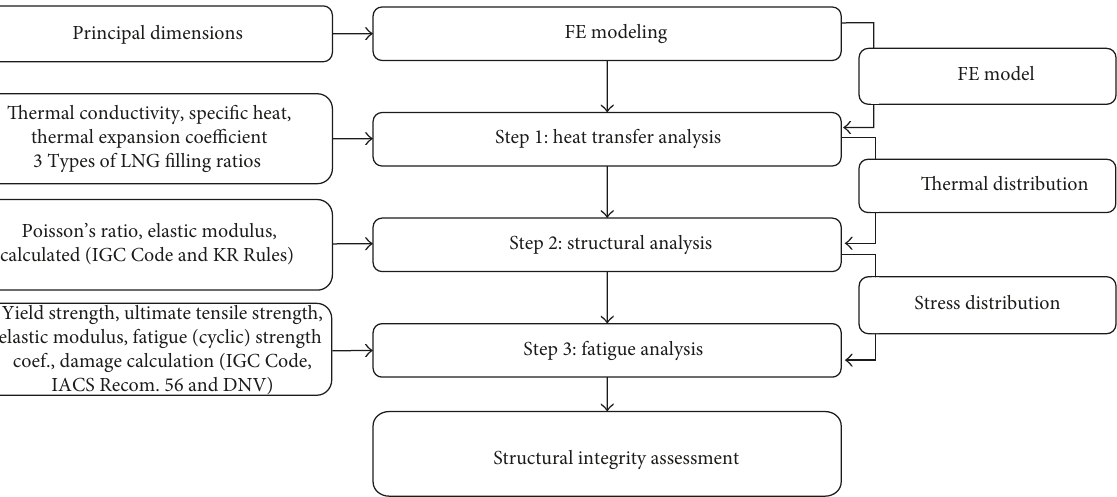
Figure 1: Flowchart of proposed structural integrity assessment of the LNG fuel